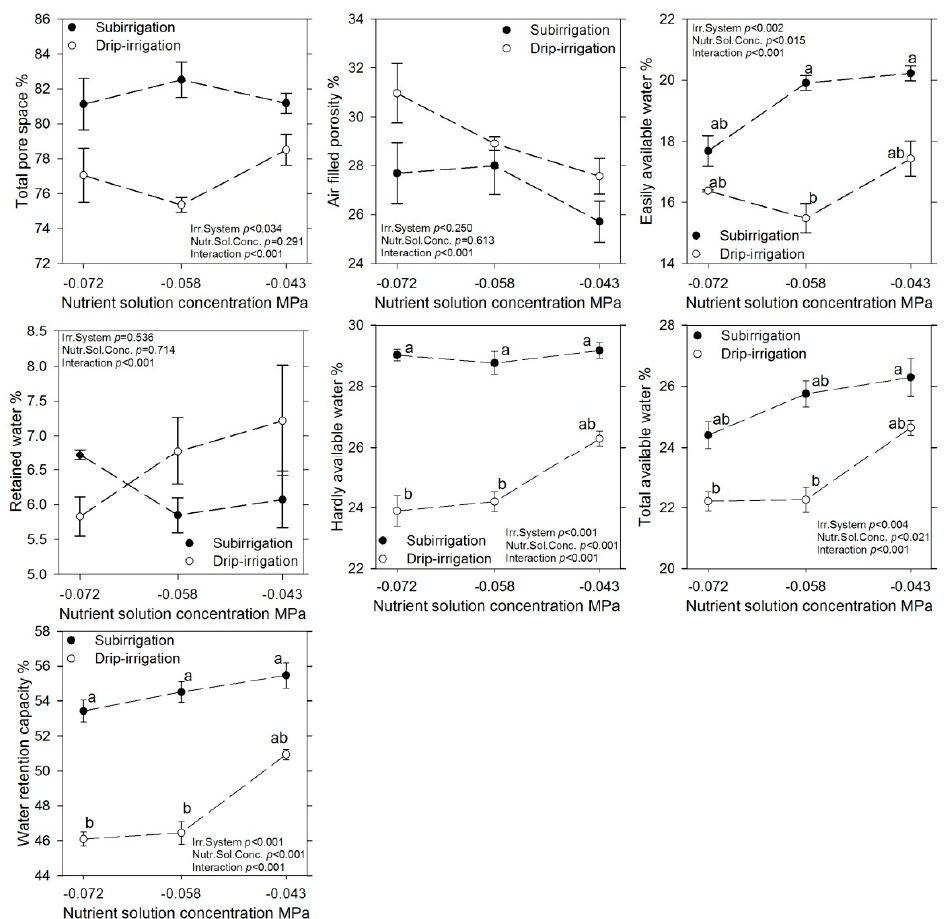
Figure 2. Substrate physical properties as affected by irrigation method and nutrient solution concentration at the termination of the experiment in Solanum lycopersicum L. (tomato) plants. Means with the same small case indicate non-significant differences according to Tukey´s multiple comparison test. Bars represent the standard error of the mean (n = 4).